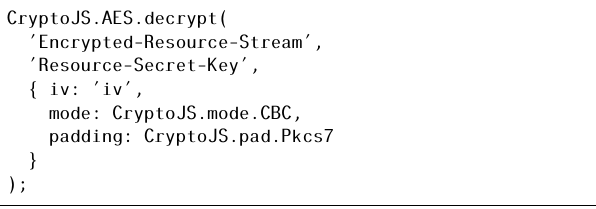
Figure 13. Javascript AES decipher